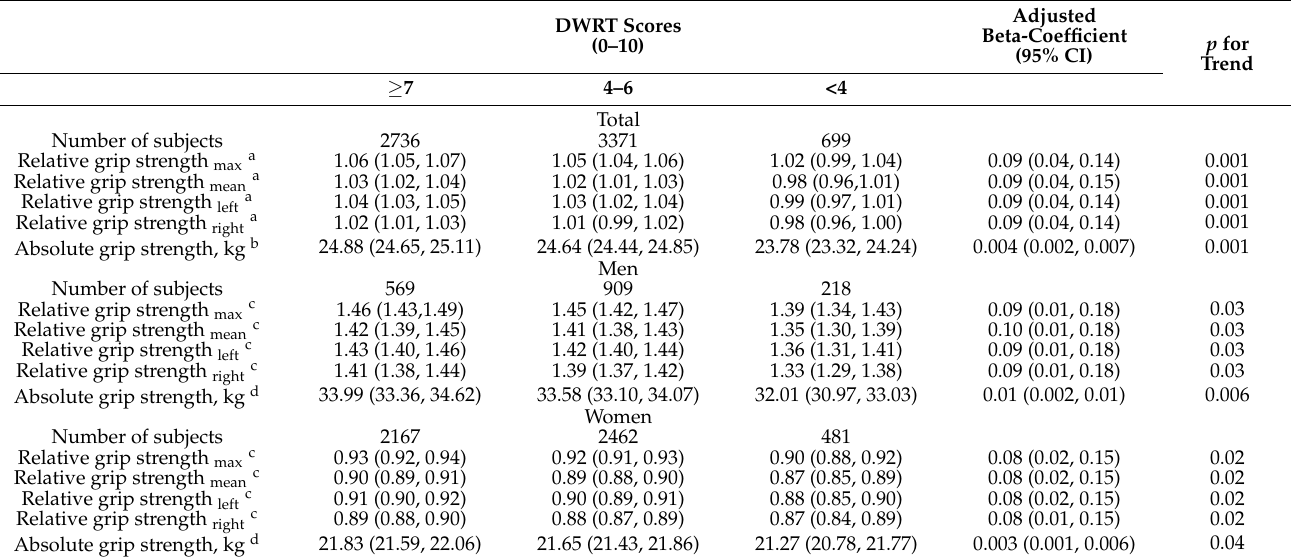
Table 3. Multivariable linear regression of hand grip strength on different Delayed Word Recall Test (DWRT) groups for males and